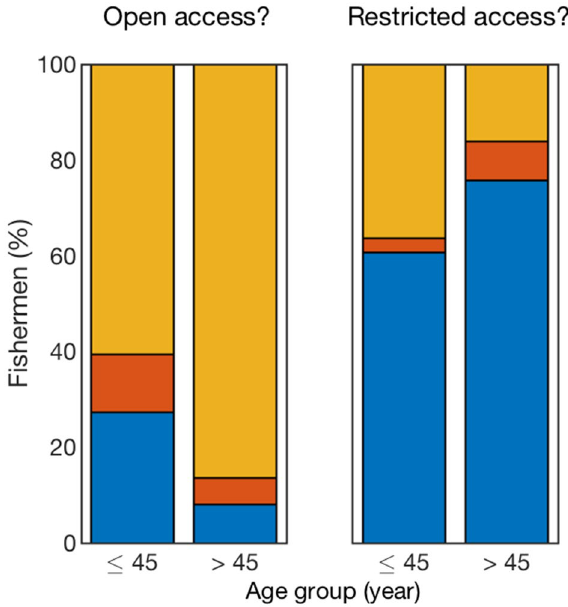
Figure 4. Distribution of fisher answers to two survey questions. ( A ) Is open access to the artificial reef by all fishers useful for fisheries management? ( B ) Is restricted access to the artificial reef a useful fisheries regulation measure? Blue, red, and orange are the percentage of fishers that answered “useful”, “useful if temporary,” and “useless”, respectively. There was a significant difference in how fishers perceived the usefulness of the artificial reef according to their level of experience. This phenomenon was also related to their understanding of fish population dynamics and fish movement and behavior (assuming that the level of experience is proportional to the age of